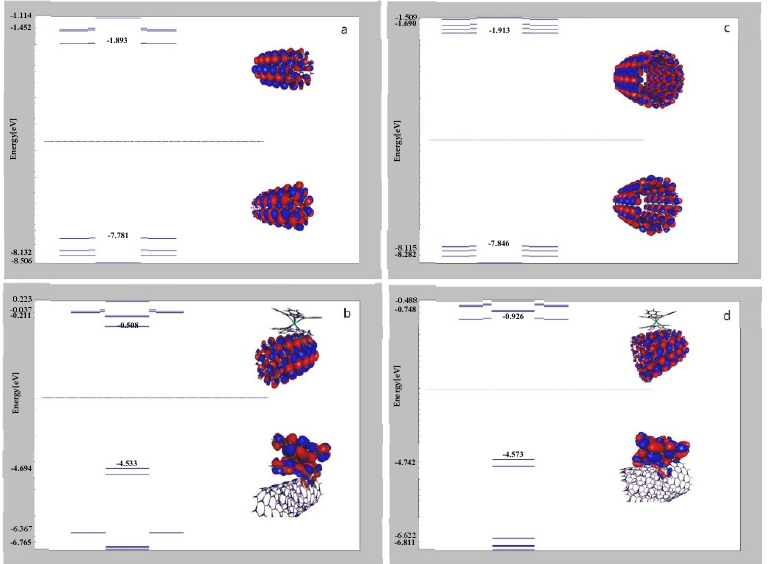
Figure 5. Energy level diagrams and frontier molecular orbitals (HOMO and LUMO): ( a ) zigzag (9,0) boron nitride nanotubes and ( b ) zigzag (9,0) boron nitride nanotubes decorated with YbPc 2 complex; ( c ) zigzag (18,0) boron nitride nanotubes and ( d ) zigzag (18,0) boron nitride nanotubes decorated with YbPc 2 complex.